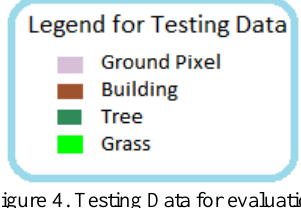
Figure 2. Process of getting automatic training data